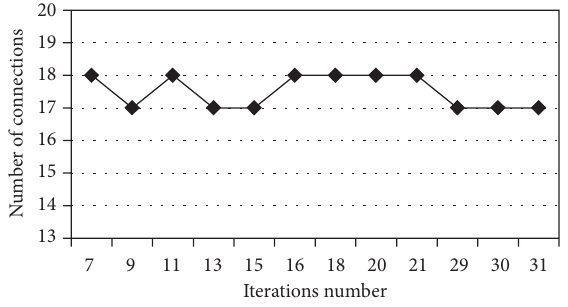
Figure 4: Energy level improvements among 𝑅 = 6